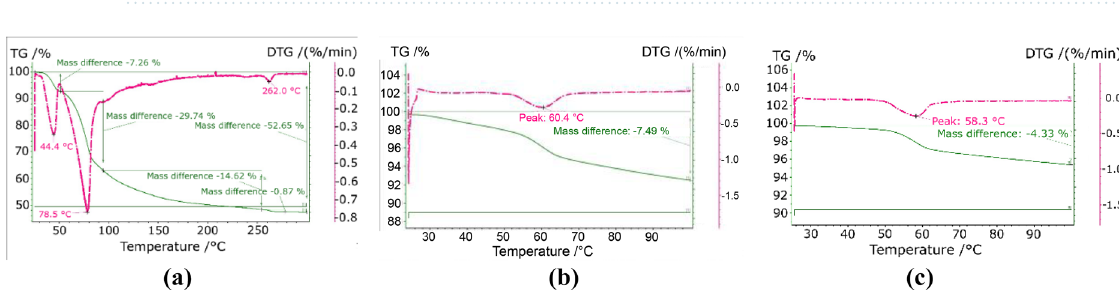
Figure 2. ( a ) EDX of Boehmite covered Aluminium plate, charged with MgSO 4 , ( b ) ATR-FTIR of Boehmite and MgSO